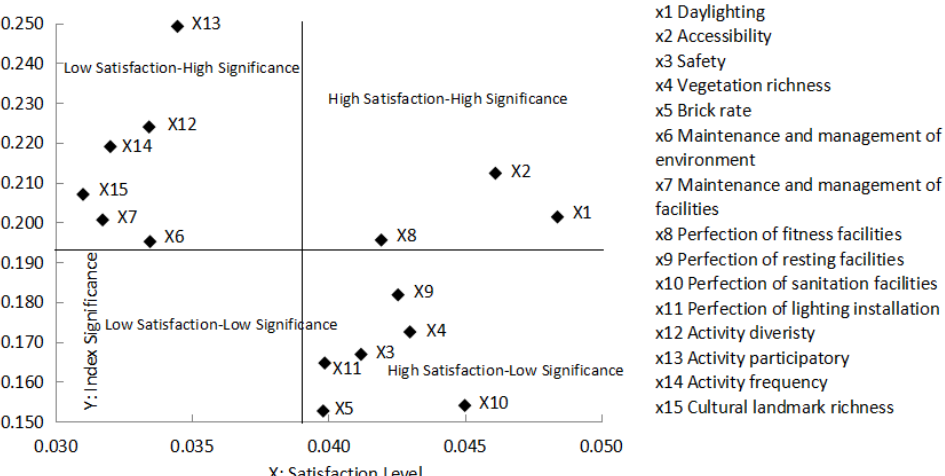
Figure 1. Quadrant distribution of public space satisfaction level–index significance of new central- ized community.